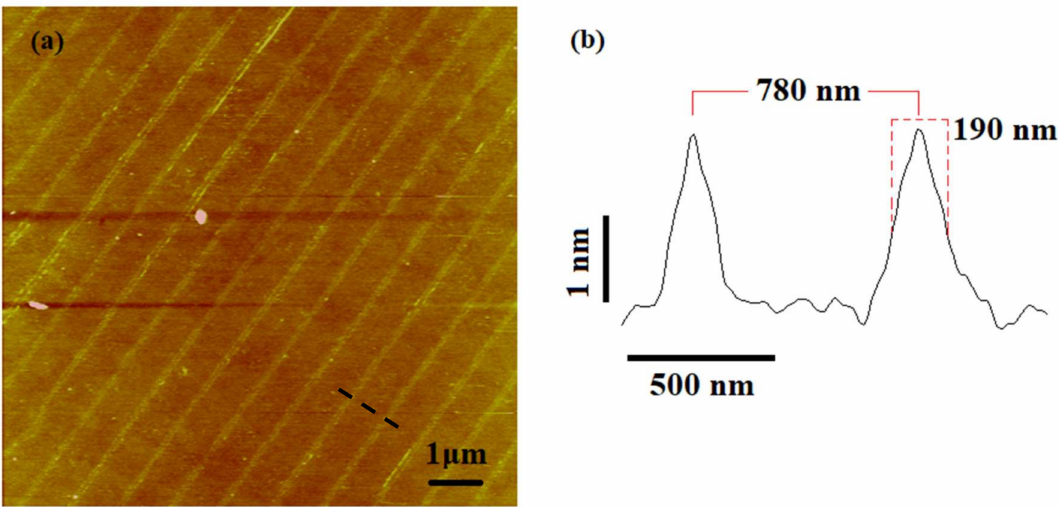
Figure 9. Schematic diagram of pattern directions. ( a ) Orthogonal direction; ( b ) Parallel direction.